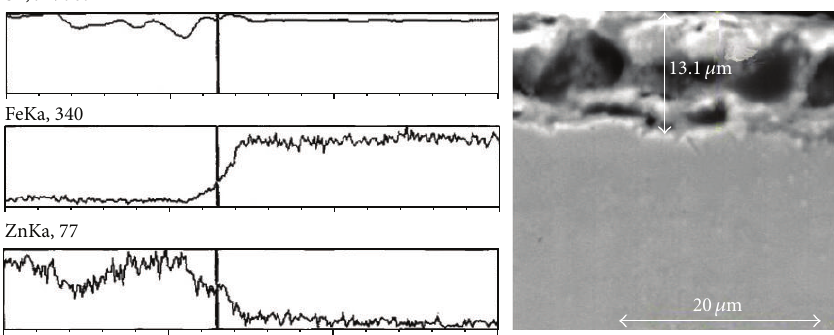
Figure 9: EDX analysis and cross section of Zn coating after shear strength under tension.